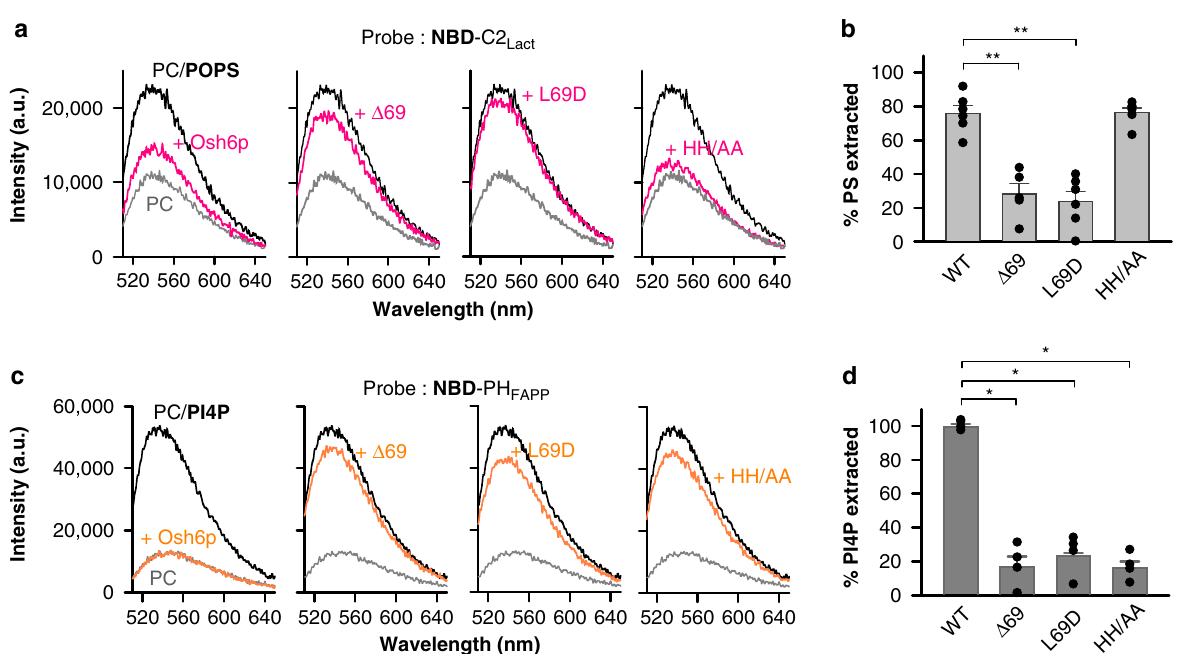
Fig. 2 Osh6p mutants extract differently PS and PI4P. a PS extraction assay. Fluorescence spectra of NBD-C2 Lact (250 nM) measured upon excitation at 460 nm in the presence of liposomes (80 µ M, 2% POPS) before (black spectrum) and after (pink spectrum) adding Osh6p or mutants (3 µ M). A reference spectrum (in gray) was recorded with pure DOPC liposomes incubated with NBD-C2 Lact . b Percentage of accessible PS extracted by each construct based on signal normalization at 536 nm. ( n = 5 – 6, ** P < 0.01, Mann – Whitney test). c PI4P extraction assay. Fluorescence spectra of NBD-PH FAPP (250 nM) ( λ ex = 460 nm) mixed with liposomes (80 µ M, 2% diC16:0-PI4P) before (black spectrum) and after (orange spectrum) adding 3 µ M Osh6p WT or mutants. A reference spectrum of NBD-PH FAPP (in grey) was recorded with PI4P-free liposomes. d Percentage of accessible PI4P extracted by each construct based on signal normalization at 536 nm ( n = 4,* P < 0.05, Mann – Whitney test). Error bars correspond to s.e.m. Source data are provided as a Source Data fi